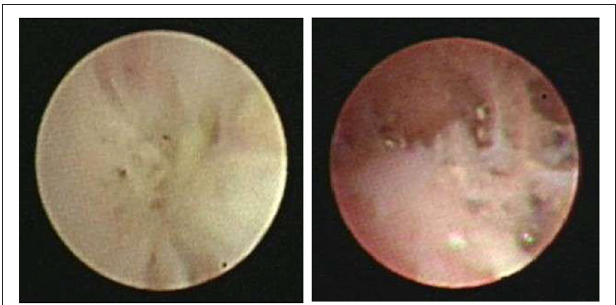
FIGURE 1 | Fiberoptic bronchoscopy revealed the obliteration of the lumen of bronchial branches, bronchial segments, or bronchial subsegments.